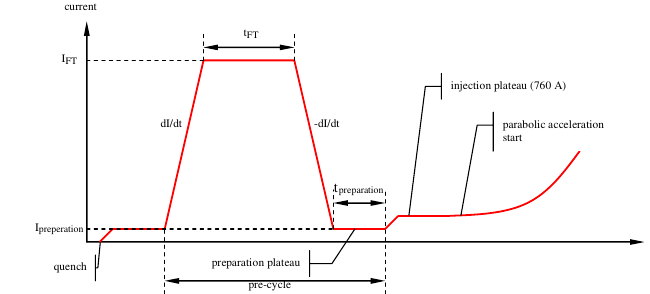
(cid:1) t (cid:2) FIG. 11. (Color) Scatter plot of the fit parameters b decay ramp 3 (cid:3) 25 mm ) and (cid:1) I that correspond to sets of (units @ R ref 3 different powering cycles in four Tevatron dipoles tested and FIG. 12. (Color) A typical precycle and the main parameters (cid:3) 0 : 198 . analyzed to date. g SB defining its 3